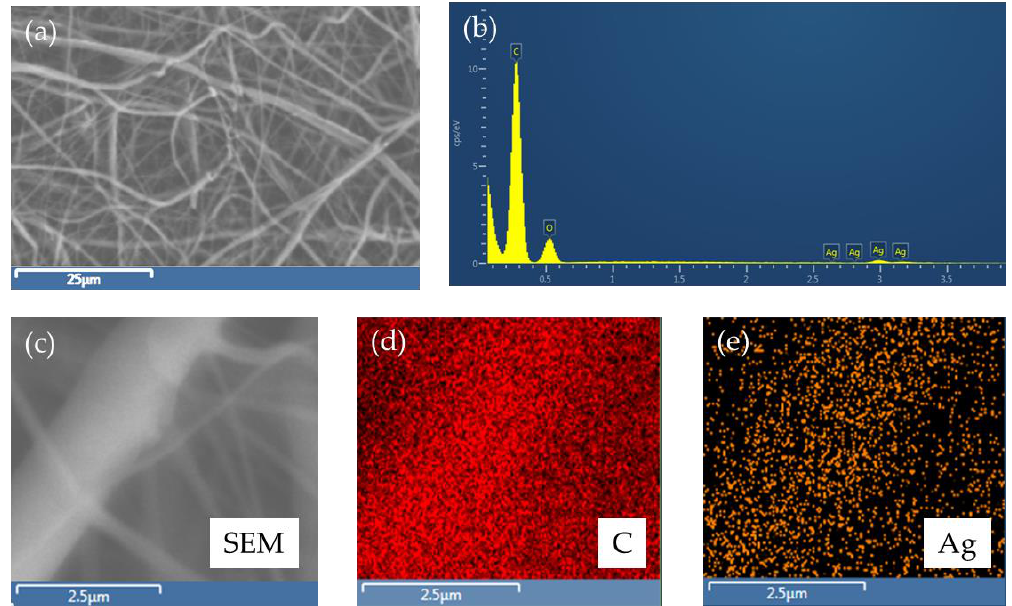
Figure 4. EDS mapping confirming presence of Ag on the Ag-coated PCL samples obtained at 5 kV operating voltage. ( a , b ) SEM and related EDS spectrum taken on a fiber bundle region; ( c – e ) SEM and related EDS mapping taken on a single fiber.